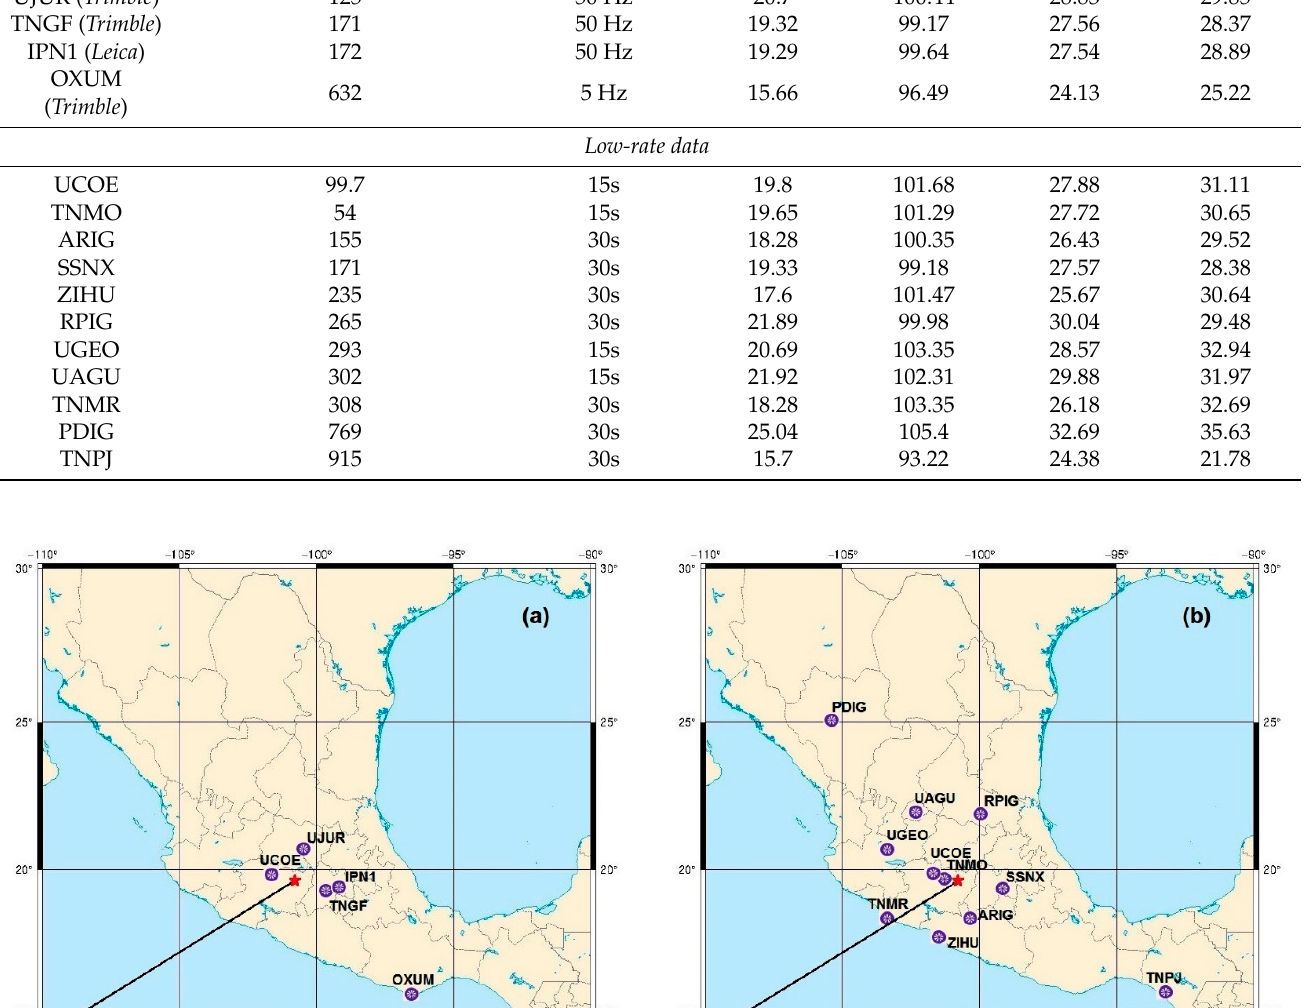
Table 2. GNSS receivers whose data were involved in the analysis.